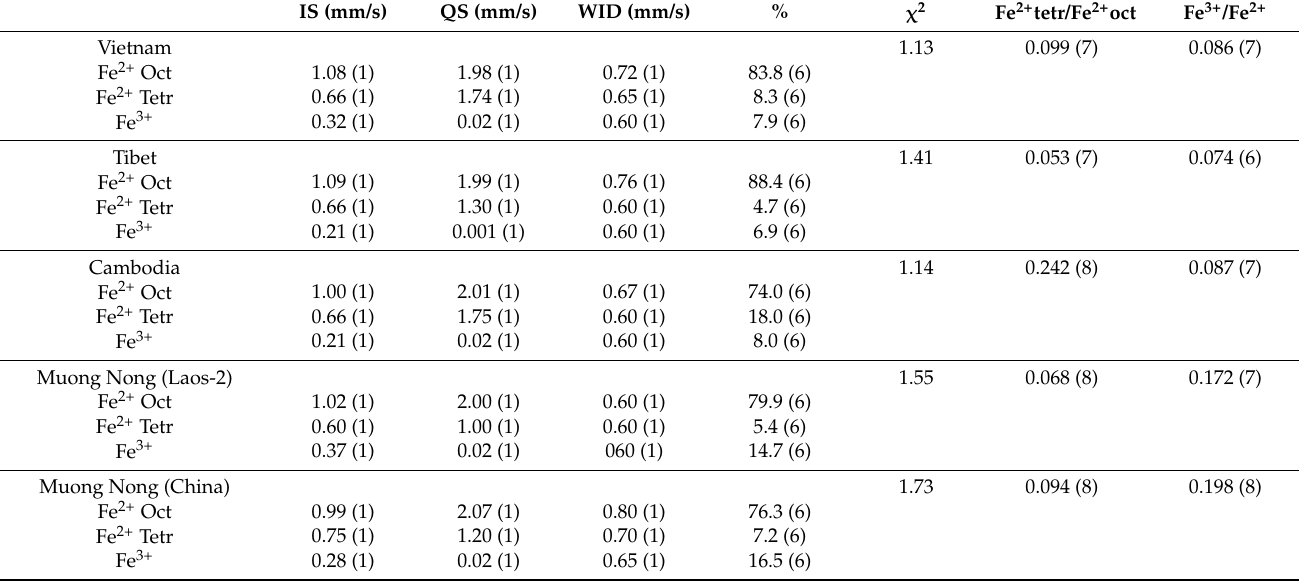
Table 9. Average hyperfine parameters obtained from the fitting procedure to spectra shown in Figure 21 for some groups of tektites. Errors in last significant digits are given in